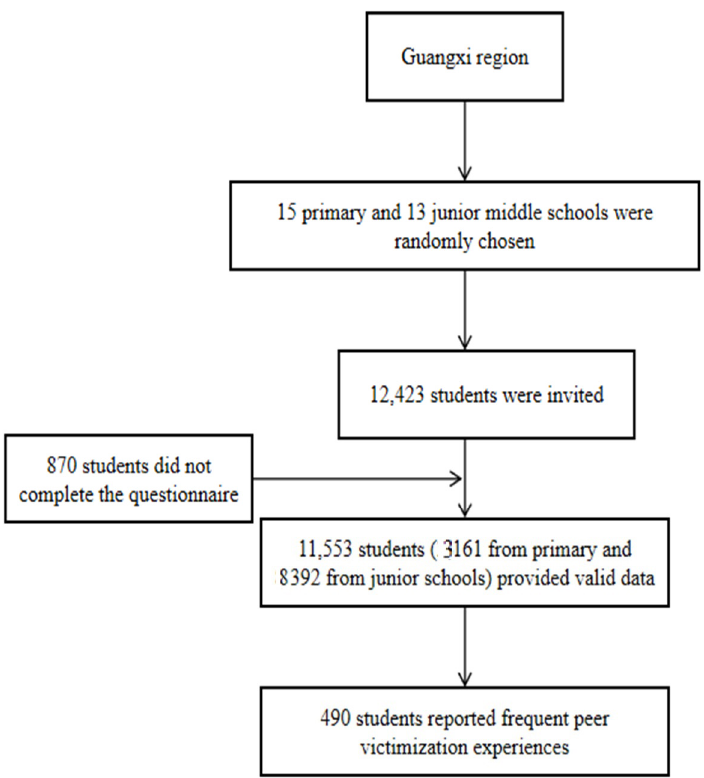
Figure 1. Flow chart of sampling and participant Figure 1 Flow chart of sampling and participant recruitment.